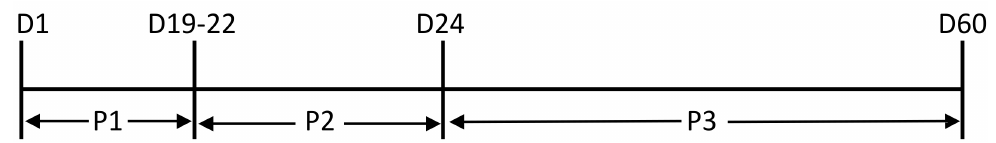
Figure 1. Experimental protocol. D1, first gestational day and beginning of paraben injection; D19–22 last gestational day and ending of paraben injection; D24, last lactational day and separation of males from females; D60, euthanasia; P1, gestational period; P2, lactational period; P3, postlactation